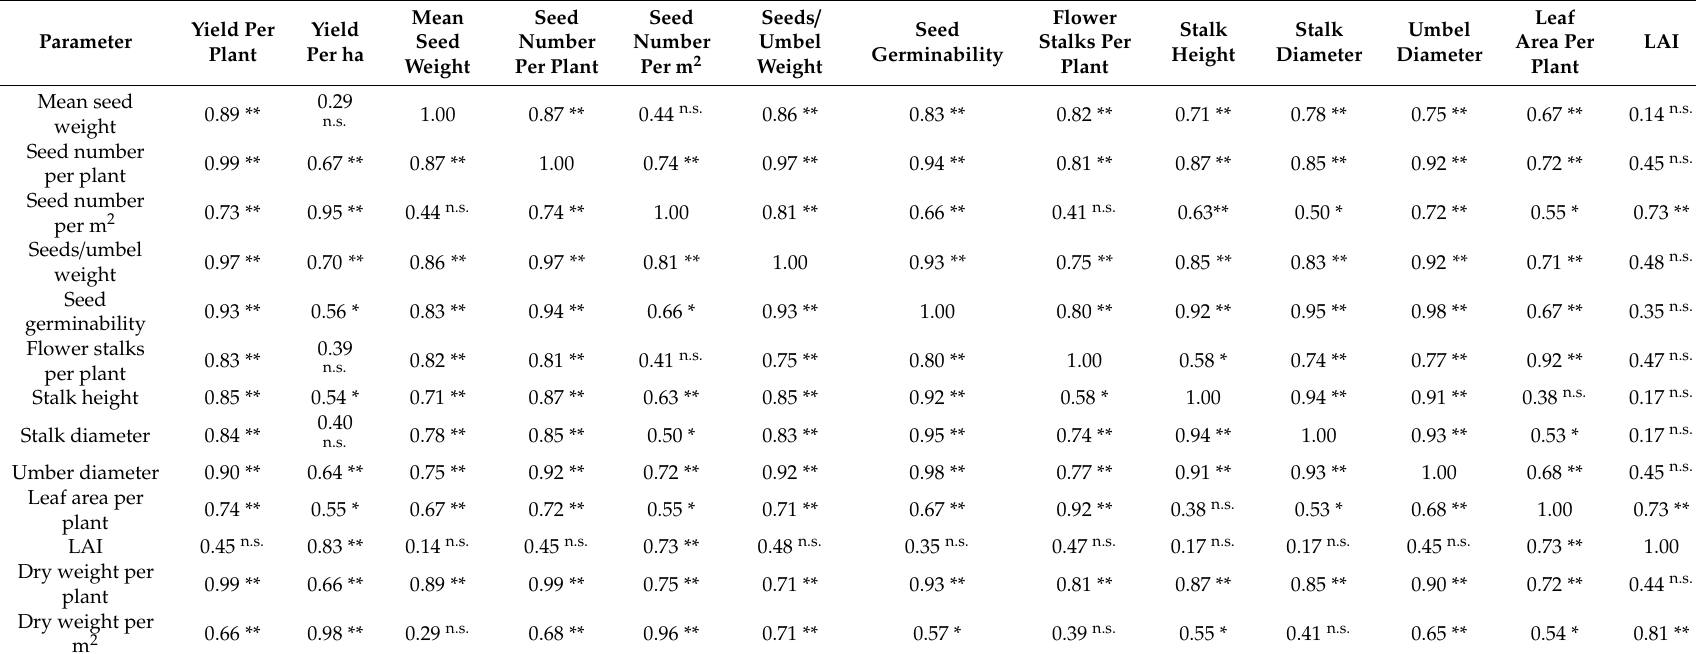
Table 4. Correlations between yield, growth, and biometrical